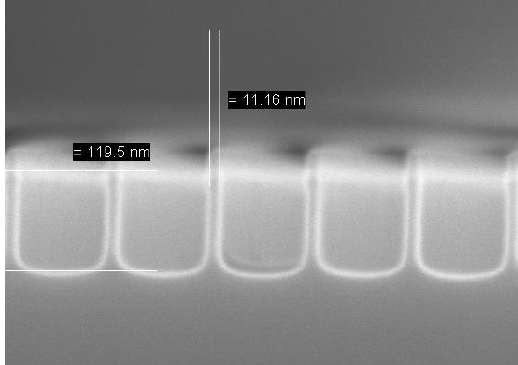
Fig. 2. Cross-sectional SEM of 11 nm Silicon fins with the remaining resist after